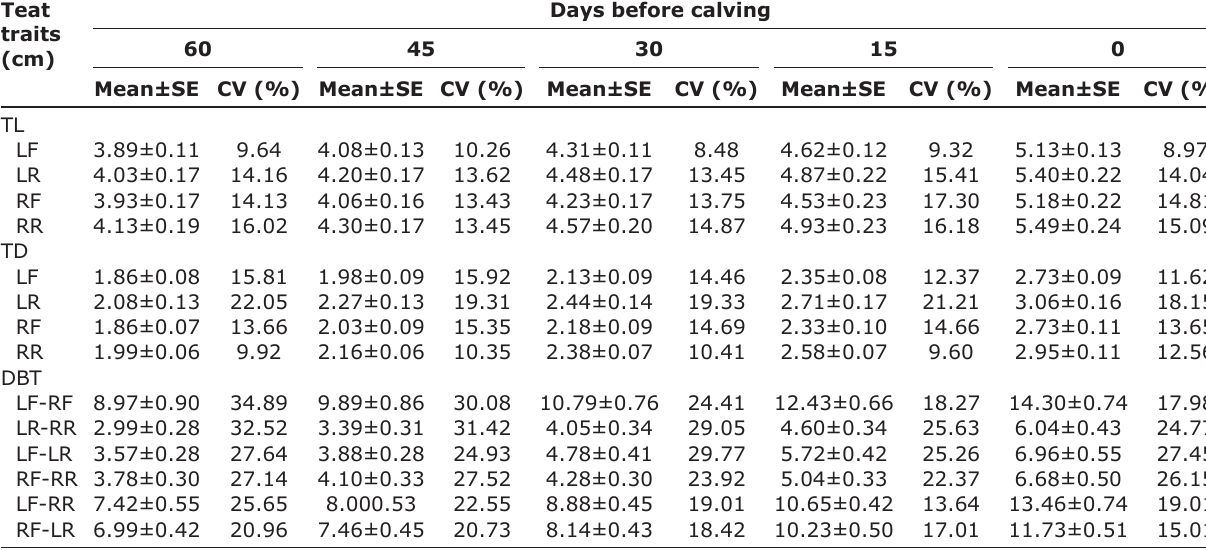
Table-3: Mean±SE and CV % of various teat traits in pregnant Nili-Ravi buffalo heifers. Teat traits (cm)